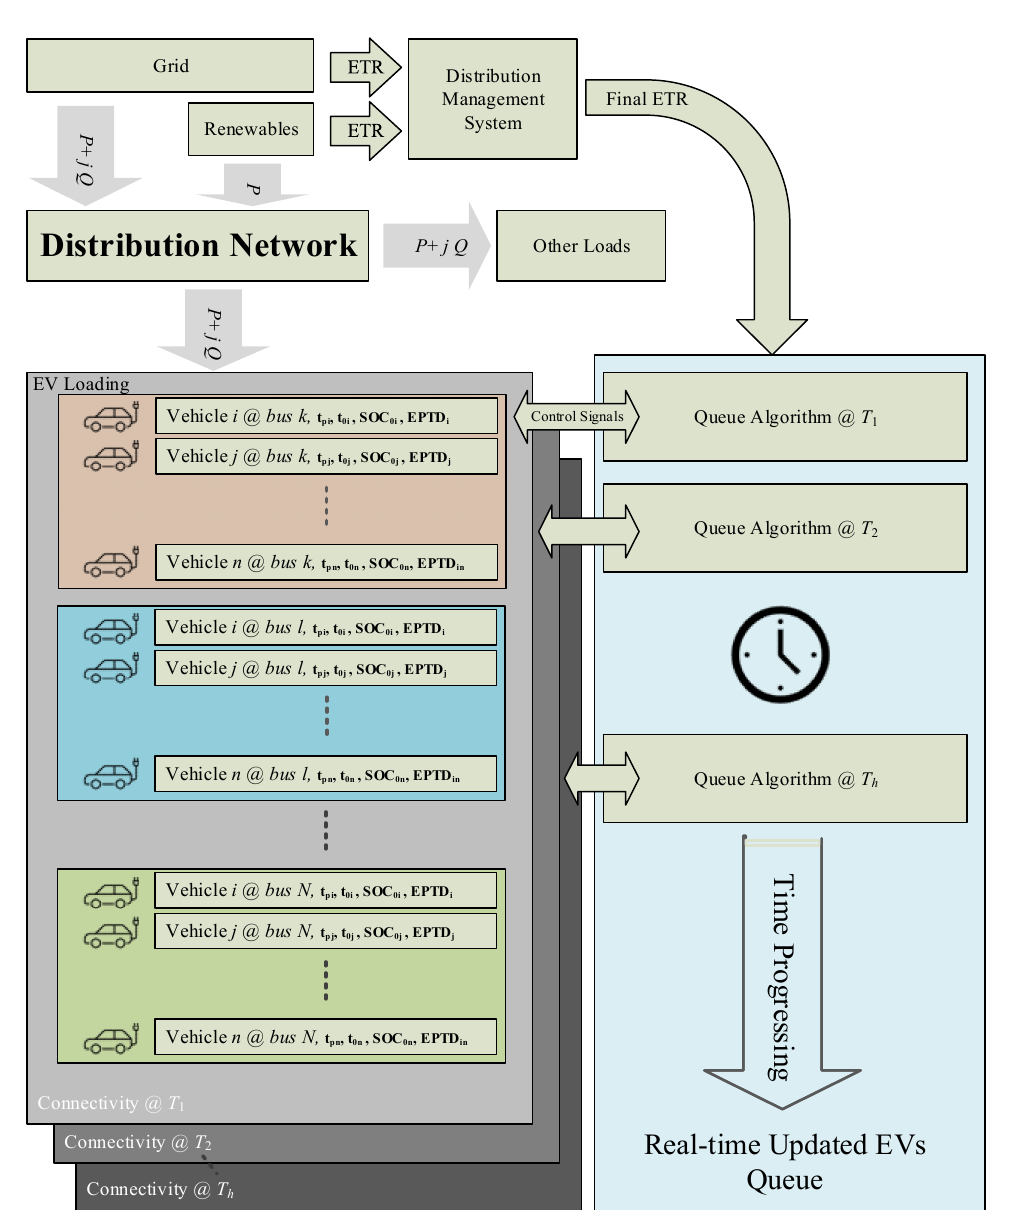
Figure 6. Queuing management strategy for demand response at instant T for EVs aggregation N, at bus k.